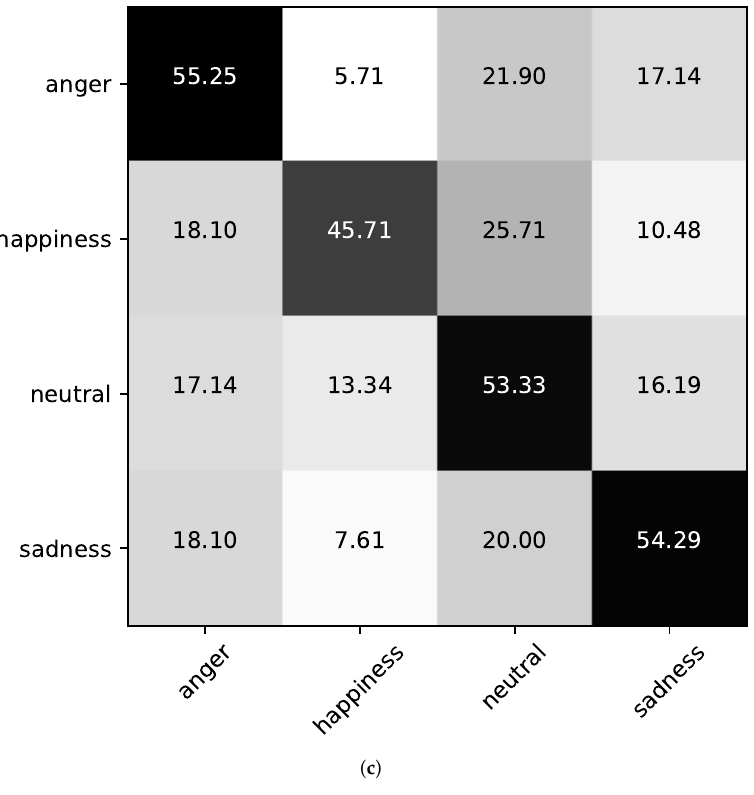
Figure 5. The confusion matrices of different methods on the CMEW dataset. ( a ) Baseline (A+V), ( b ) Ours (wo corr), ( c )